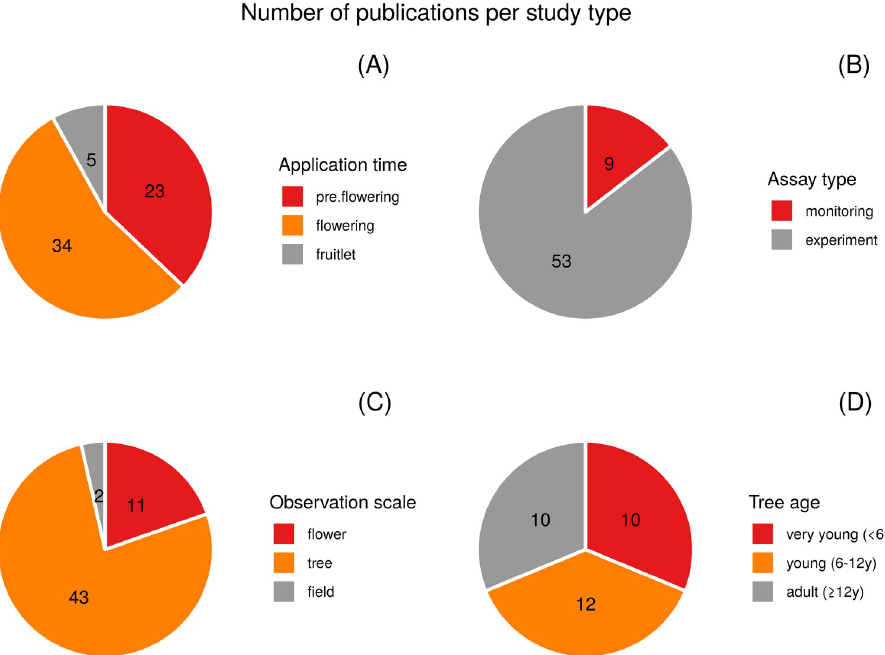
Fig 5. Characteristics of studies. Number of publications per application time (A), assay type (B), observation scale (C) and tree age (D). Note: the total number of publications does not necessarily have to be 58 as in some cases, e.g. tree age was not specified, and several observation scales were used in other cases.